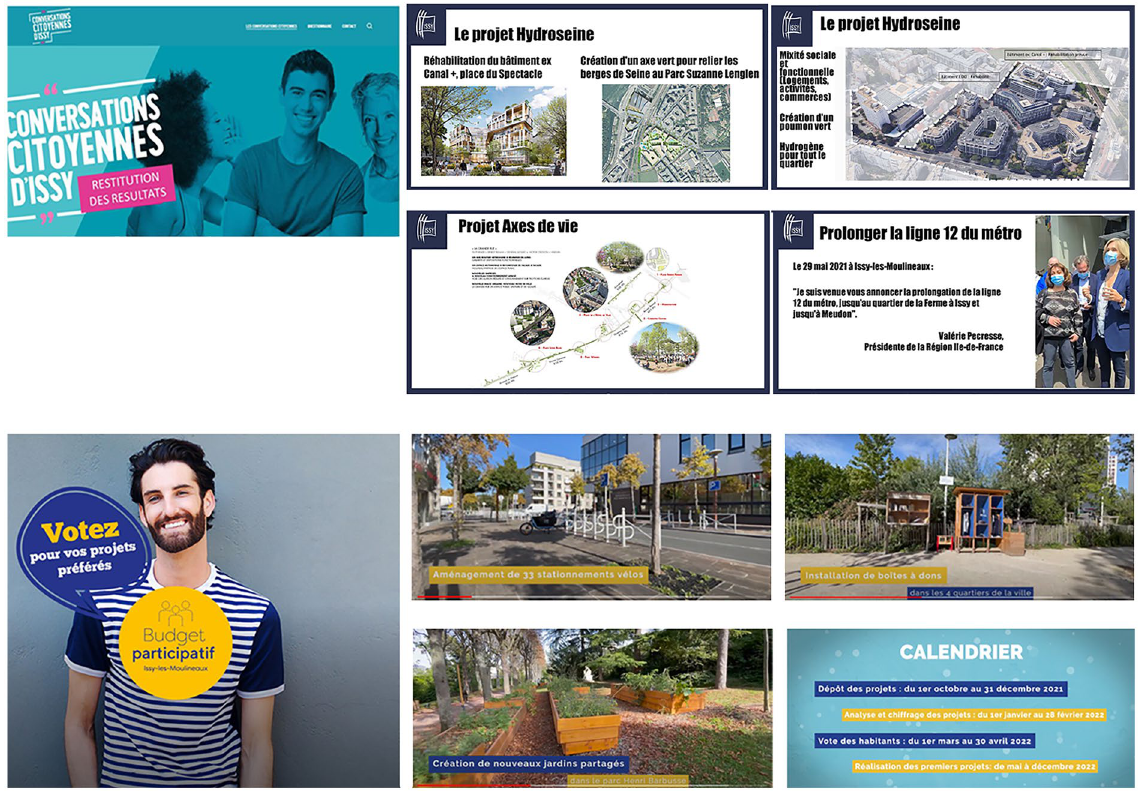
Fig. 6 Conversations citoyennes d’Issy-les-Moulineaux and some ideas that have been proposed (up). Budget participatif d’Issy-les-Moulineaux and some of the results in terms of urban fornitures and regeneration of the public space (down). Source: authors elaboration from Issy-les-Moulineaux web site public